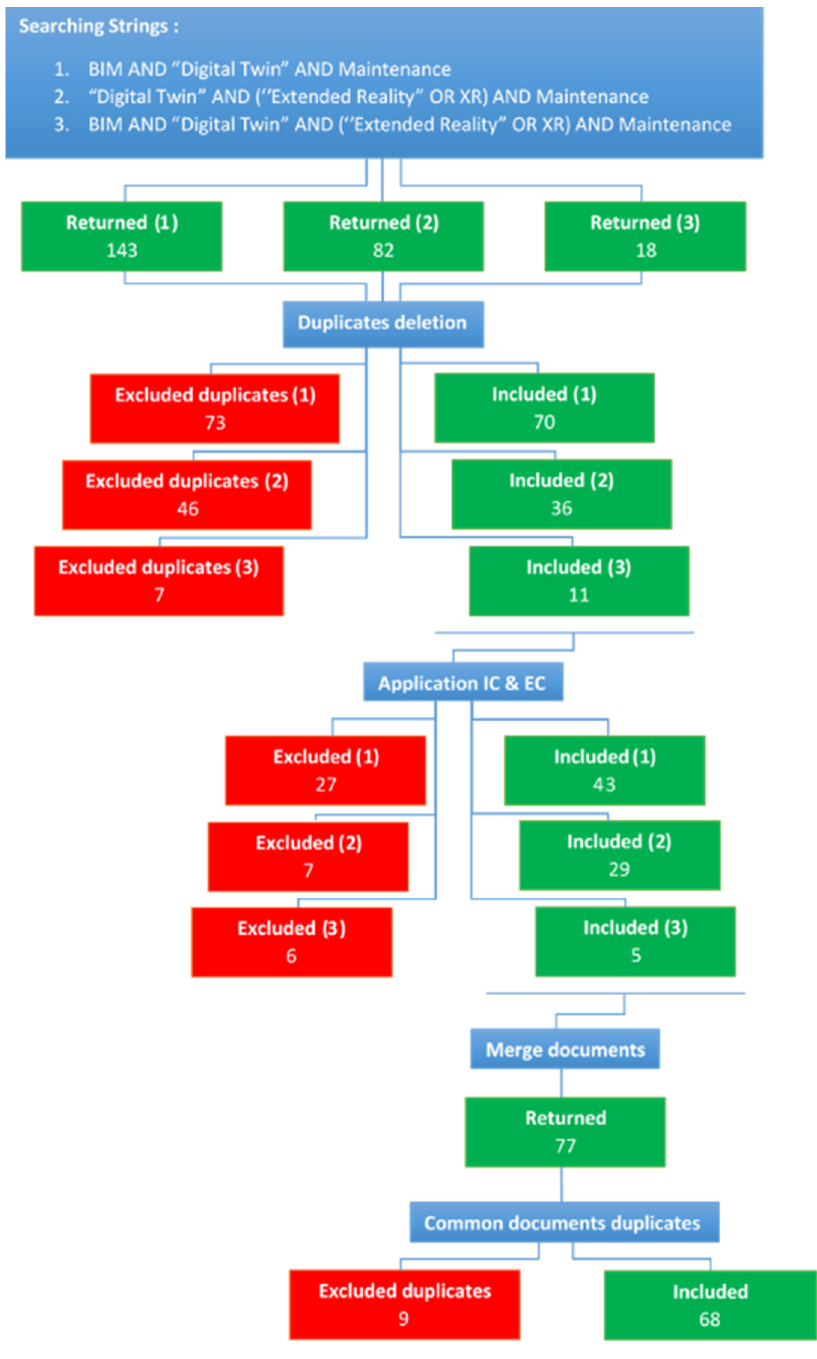
Figure 3. Selection of studies for primary studies for systematic review starting from 243 papers.